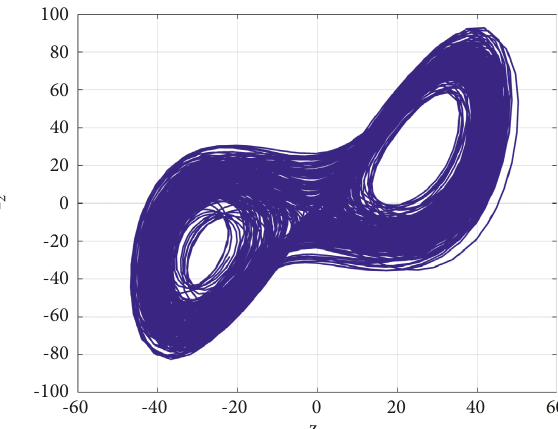
Figure 6: A hyperchaotic attractor of model (1) for a � 12 and ( b, c, d ) � ( 8 , 90 , 6 ) .